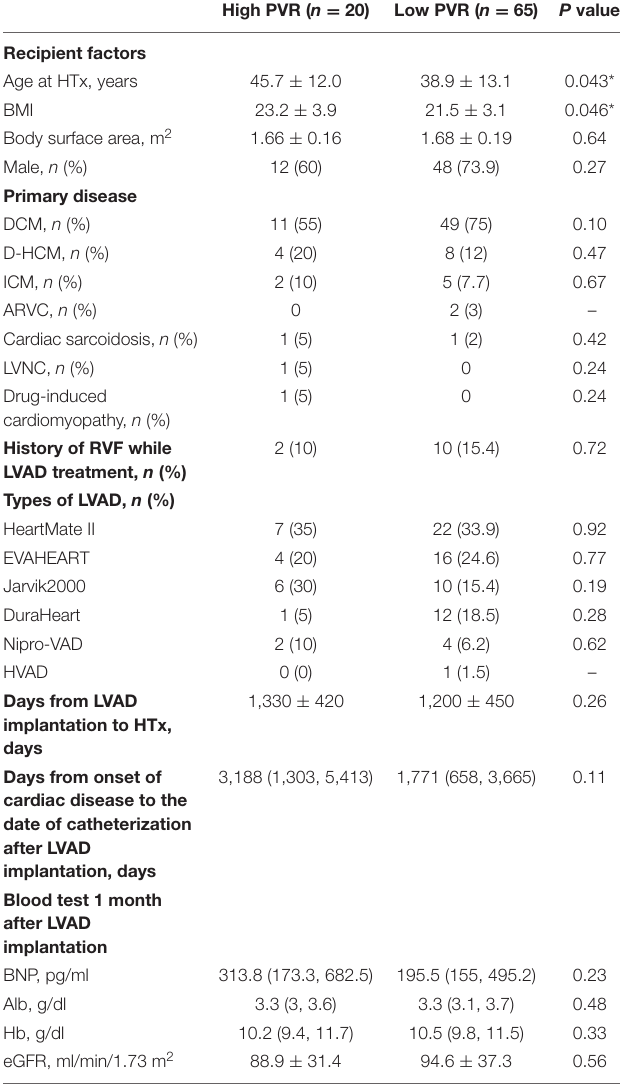
TABLE 1 | Baseline demographic and clinical parameters of recipients in two groups.